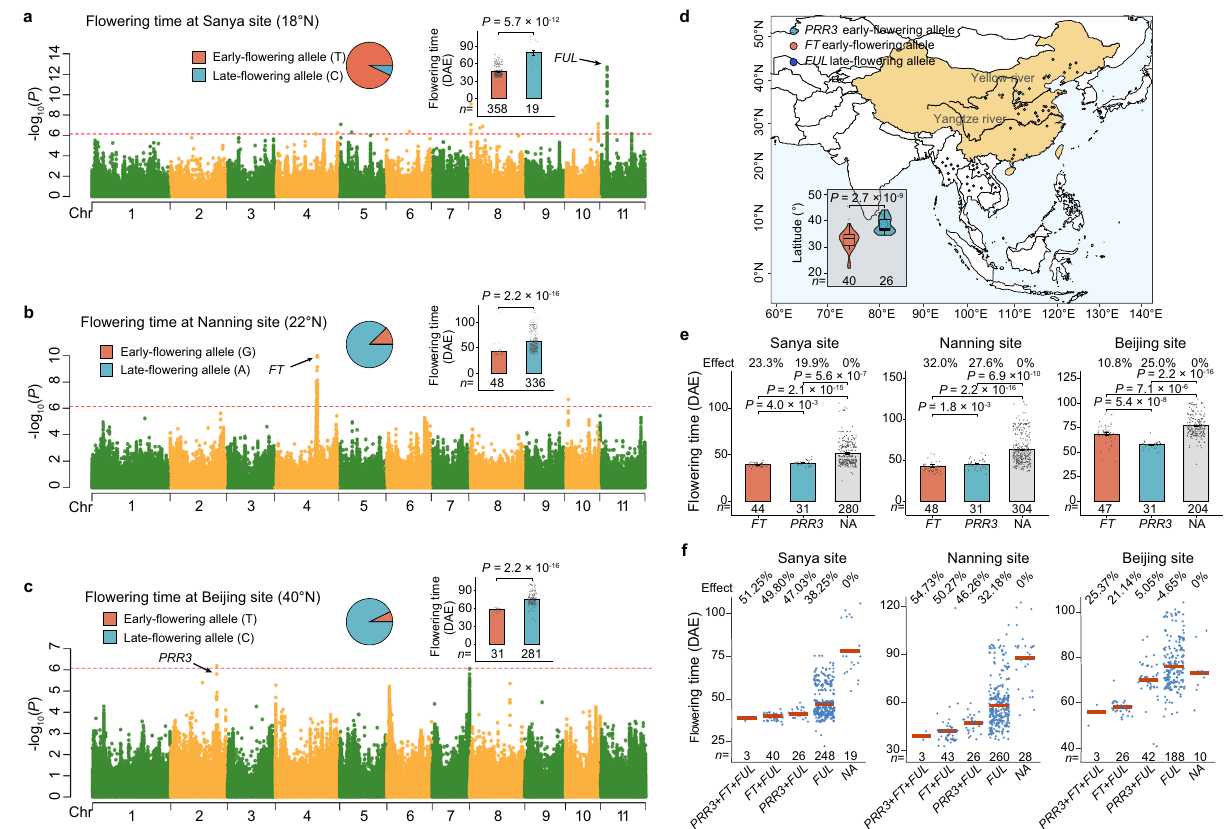
Fig.4|Thegeneticarchitectureunderlying fl oweringtimecontrolfromlowto high latitudes.a – c Manhattan plots of GWASfor fl owering-time data measured in Sanya(18°N)in2021( a ),Nanning(22°N)in2020( b ),andBeijing(40°N)in2021( c ). Red horizontal dashed line indicated the Bonferroni-corrected signi fi cance thresholds of GWAS ( α =1). Pie charts represented allelic frequencies of the major associated loci. The bar plots displaythe fl owering time oflandraces carrying each allele of the identi fi ed major loci. DAE, days after emergence. The number ( n ) of landraces carrying each allele is shown below. d The geographical distributions of landracescarryingtheearly- fl oweringallelesof FT and PRR3 ,andthelate- fl owering allele of FUL , respectively. The map was created using the map_data() function in the R package ggplot2. The violin plot showed signi fi cant differences in latitudes between landraces carrying the early- fl owering allele of FT ( n =40) and PRR3 ( n =26), respectively. In the box plots, central line: median values; bounds of the box: 25th and 75th percentiles; whiskers: 1.5*IQR (IQR: the interquartile range